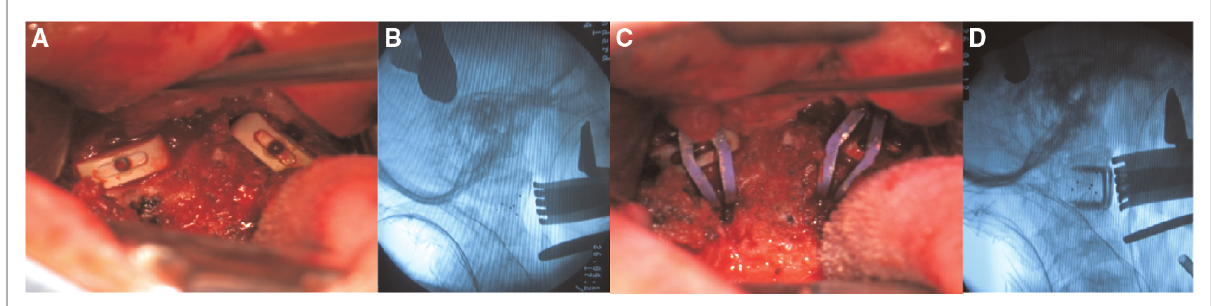
FIGURE 2 Intraoperative procedures. ( A,B ) The bilateral intraarticular cages were implanted and intraoperative fl uoroscopy showed satisfactory atlantoaxial reduction. ( C,D ) Two C-JAWS staples were fi xed and intraoperative fl uoroscopy showed satisfactory location of